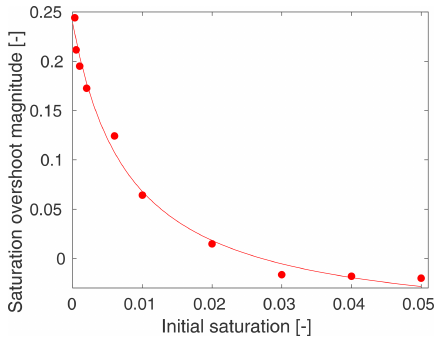
Figure 7. Dependence of the saturation overshoot magnitude on ini- tial saturation at 25min. Saturation overshoot magnitude is com- puted even for diffusion-like profiles (see the text for the method- ology). A hyperbolic relation f (x) = ax + b fitted to the simulated cx + d data has a R 2 value of 0 .